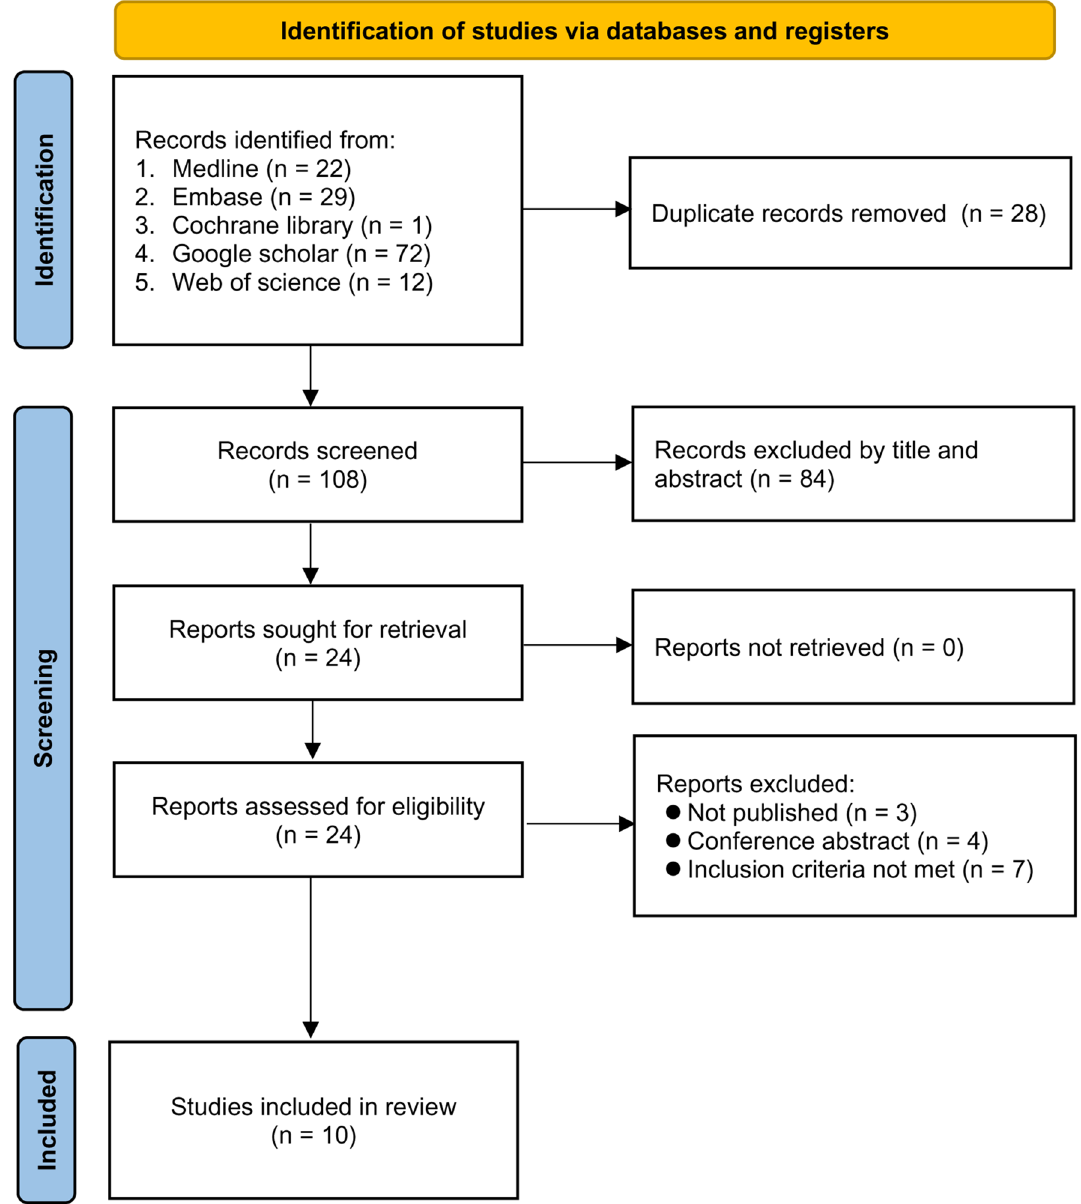
Figure 1. Summary of the process of study selection for the current